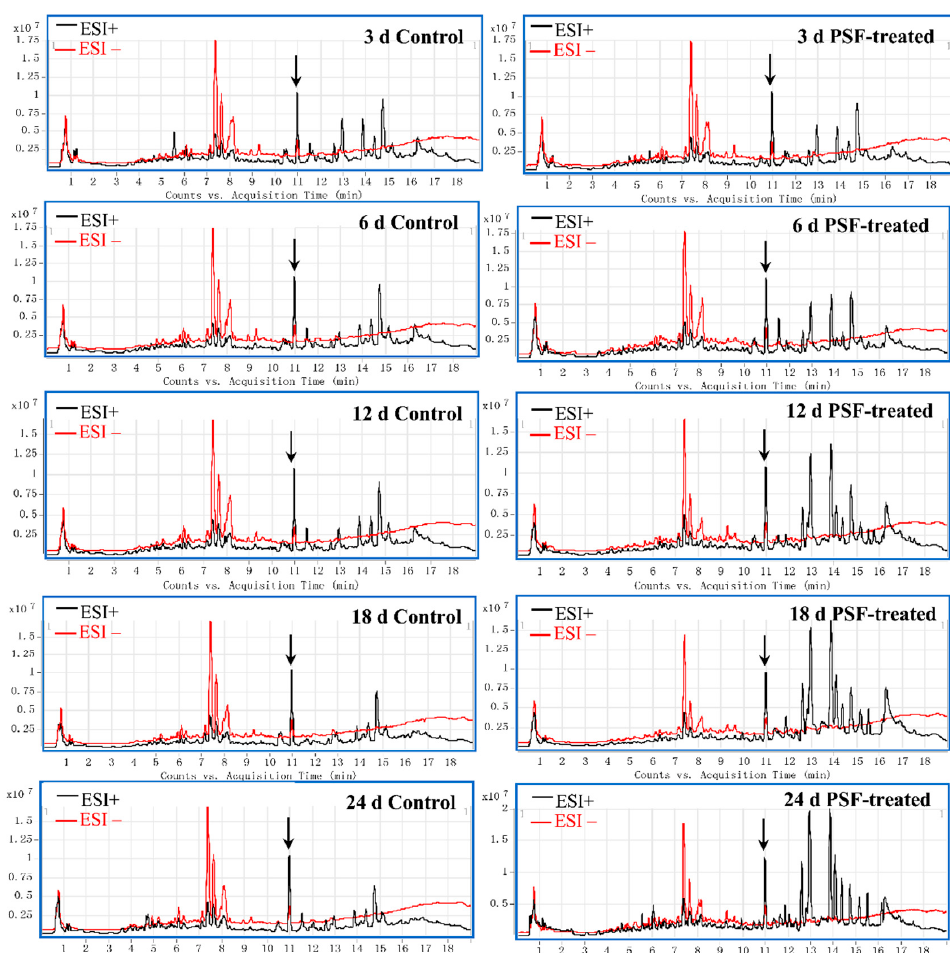
Figure 1. Typical ultra-high-performance liquid chromatography-high resolution mass spectrometry (UHPLC-HRMS) total ions chromatograms (TICs) of methanol extracts from the control and polysaccharide fraction (PSF)-treated S. miltiorrhiza hairy roots collected at 3, 6, 12, 18, and 24 d post-elicitation. ESI + : black line; ESI − : red line. The peak indicated by the arrow was casticin (C 19 H 18 O 8 ) added into the extraction solvent methanol as an internal standard.